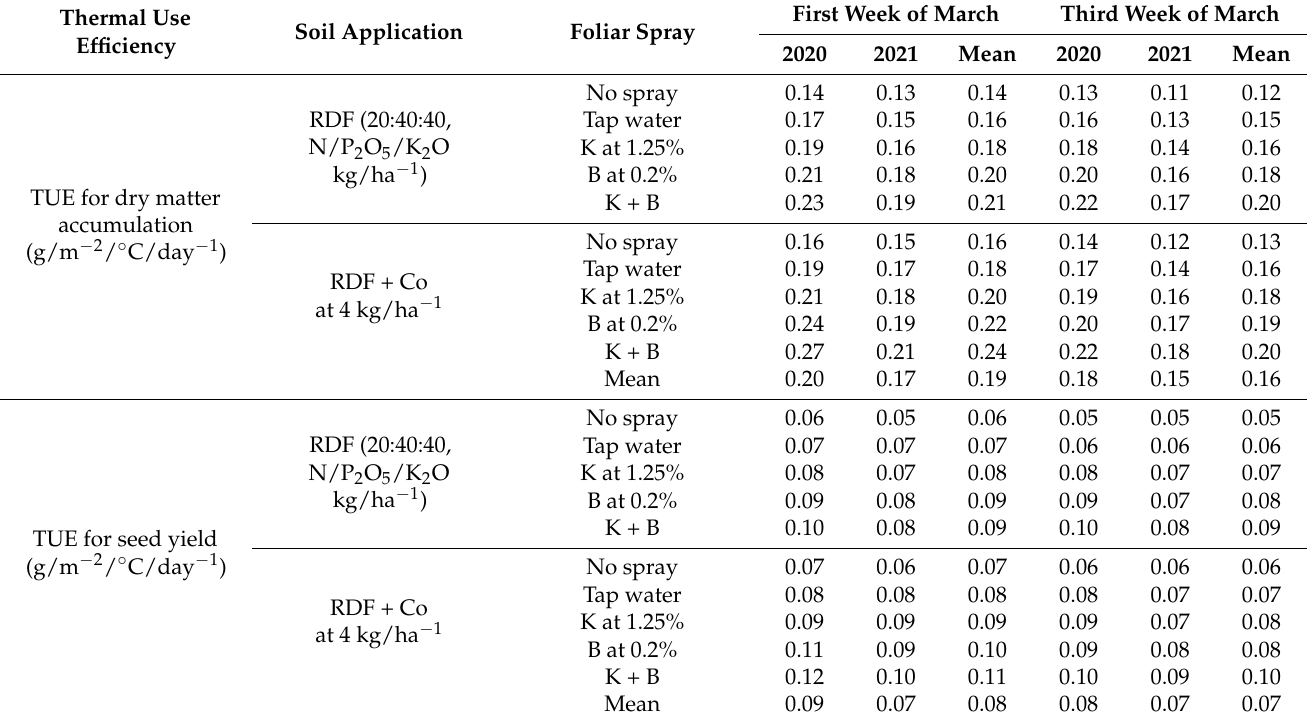
Figure 3. Impact of HTU on seed yield of black gram in ( A ) 2020 and ( B ) 2021. 3.4. Thermal Use Efficiency (TUE) of Black Gram The TUE of black gram for the final dry matter production and seed yield were found to be higher for the first date of sowing in both years of sowing (Table 12). The mean TUE ranged to the tune of 0.19 and 0.16 g/m − 2 / ◦ C/day − 1 for dry matter accumulation and 0.08 and 0.07 g/m − 2 / ◦ C/day − 1 for seed yield with respect to the first-week-of-March- and the third-week-of-March-sown black gram, respectively. Table 12. Thermal use efficiency (TUE) of spring–summer black gram sown on different dates and at different nutrient schedules.